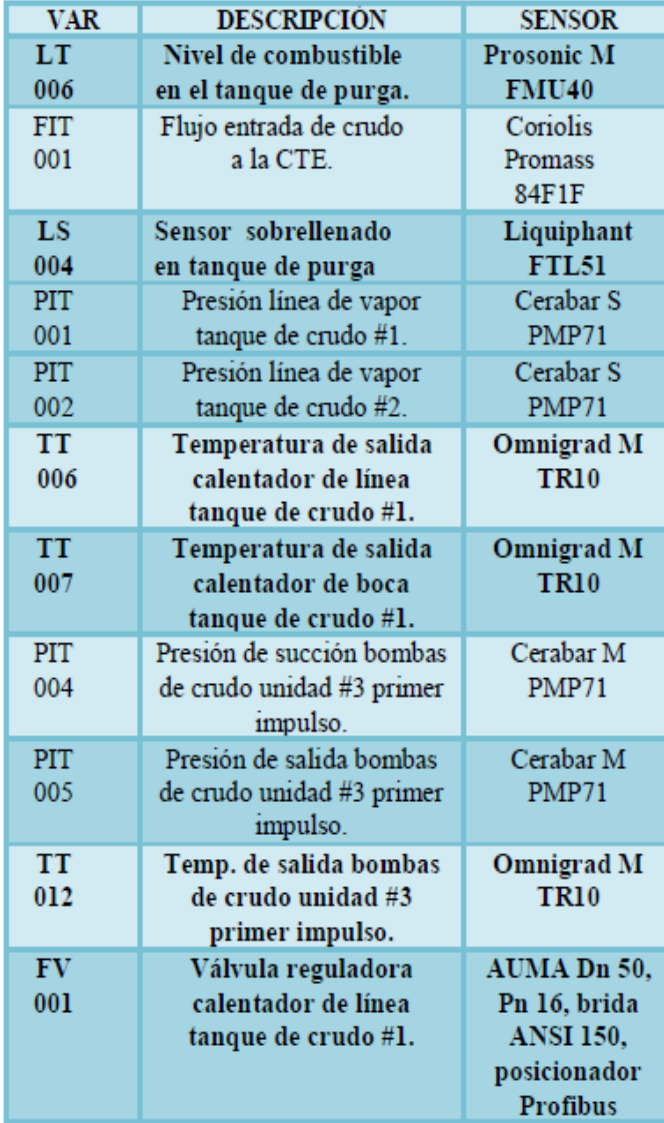
Figura 6: Profibus Power Hub ubicado en el campo. Fuente: Los Autores,